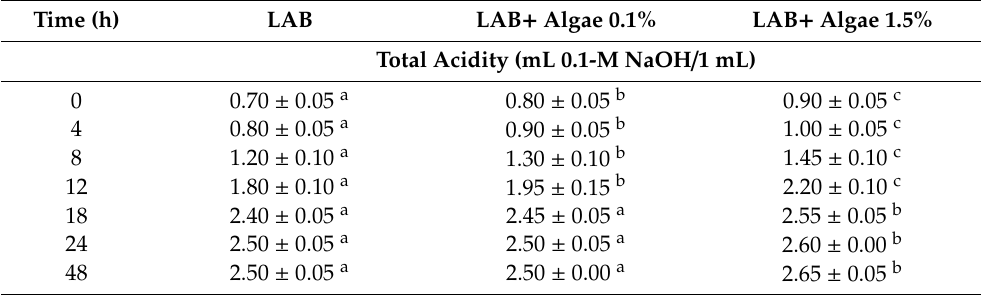
Table 1. E ff ect of algae Chlorella vulgaris on the total titratable acidity of Lactobacillus brevis ŁOCK 0944. Time (h)